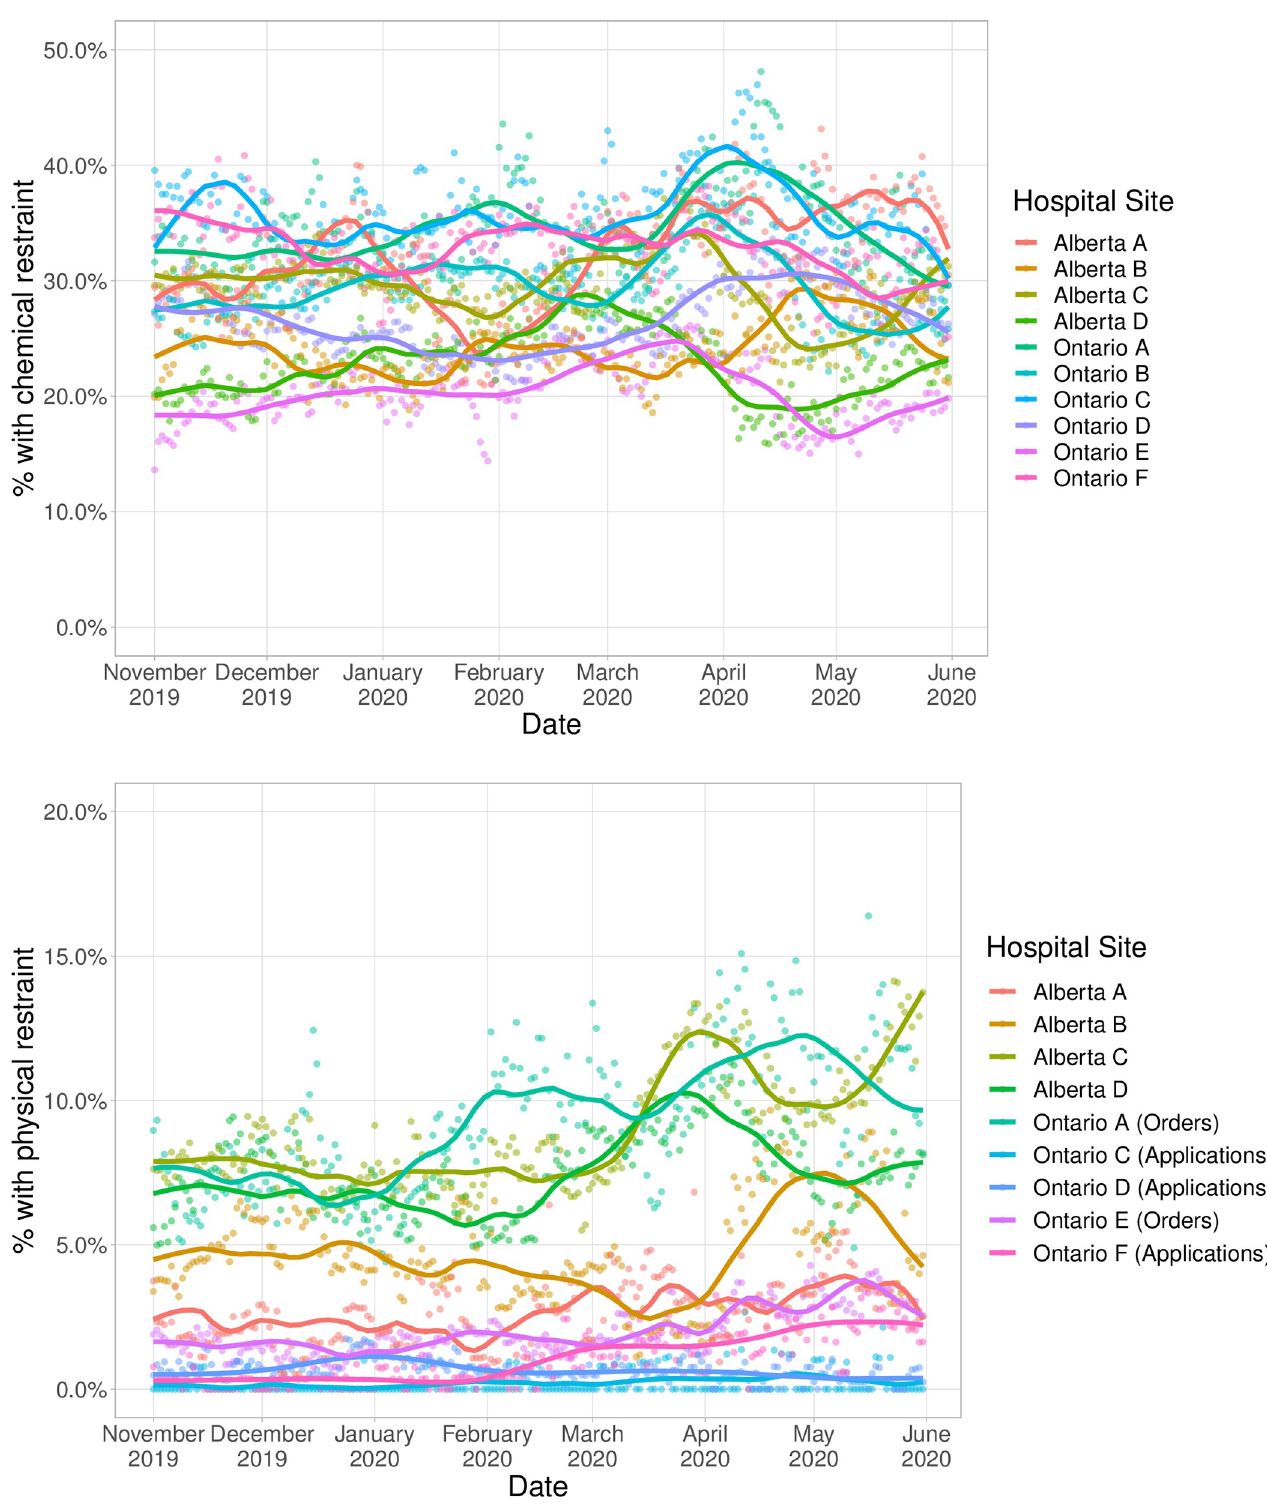
Fig 2. a. Proportion of older adults ( � 65) admitted to acute care hospitals who were ordered chemical restraints in Alberta and Ontario, November 2019 to May 2020, by hospital site. b. Proportion of older adults ( � 65) admitted to acute care hospitals who were ordered chemical restraints in Alberta and Ontario, November 2019 to May 2020, by hospital site.